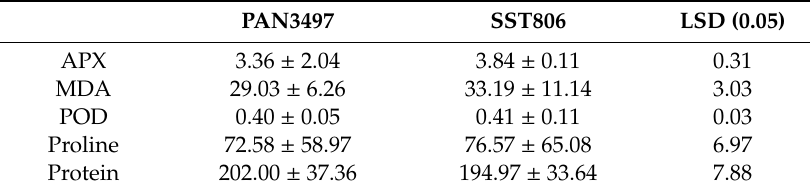
Table 3. Average values for measured parameters in two genotypes with three treatments over two sampling